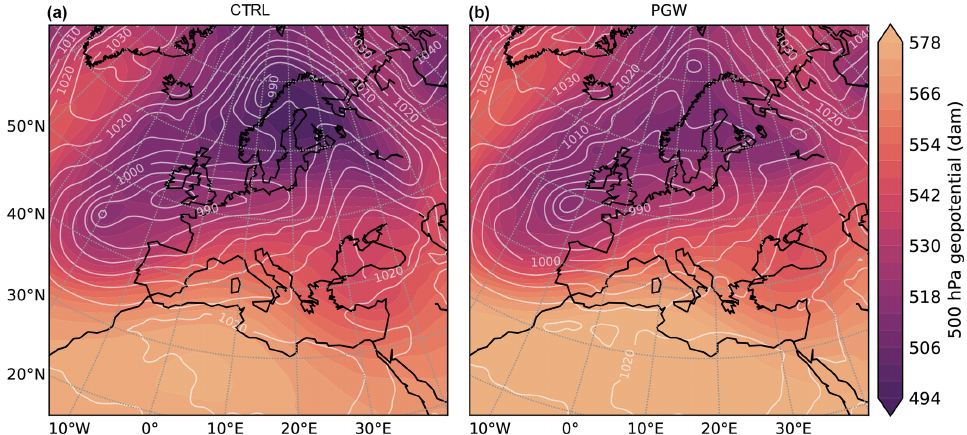
Figure 1. Snapshot of 500hPa geopotential and mean sea level pressure in a CTRL and PGW-driven simulation representing past and future conditions, respectively. Shading shows the geopotential as indicated by the color bar. White contours show mean sea level pressure (hPa). (a) Evaluation run driven by the ERA-Interim reanalysis. (b) PGW simulation of the same time step. The time of the evaluation run is 30 December 2009 at 00:00UTC. More details on the model setup can be found in Table A1. Note how the lateral boundary forcing serves to approximately maintain the circulation in the lateral boundary zone, while the system evolves freely in the interior of the domain. Also, the geopotential is generally higher in the PGW simulation shown in panel (b) because of higher atmospheric temperatures.